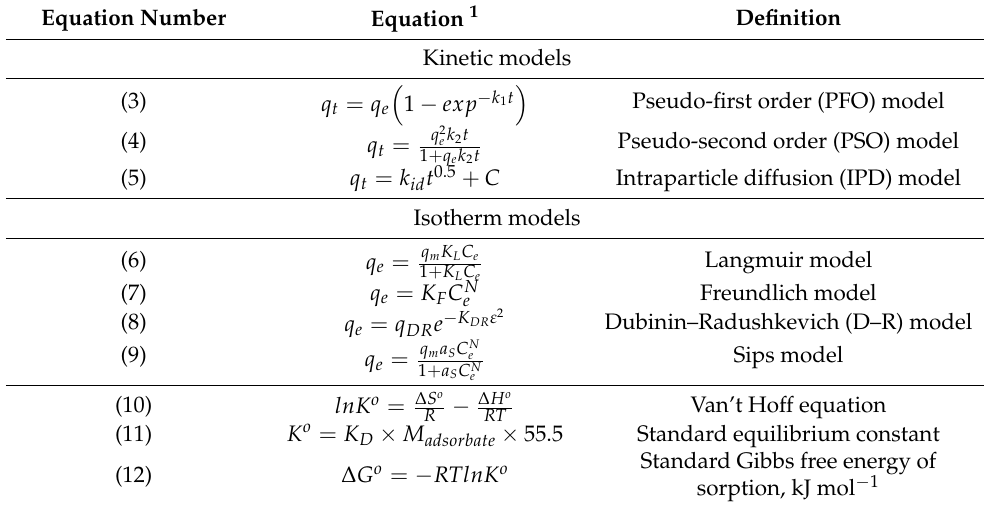
Table 1. Equations of the models commonly used for the theoretical analysis of the sorption